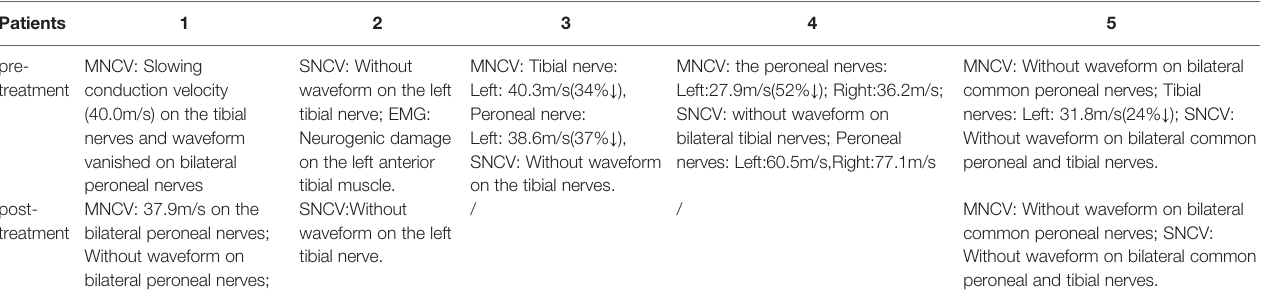
weakness Strenuous walking with others ’ help, and occasionally falling Clinical signs (both lower limbs)